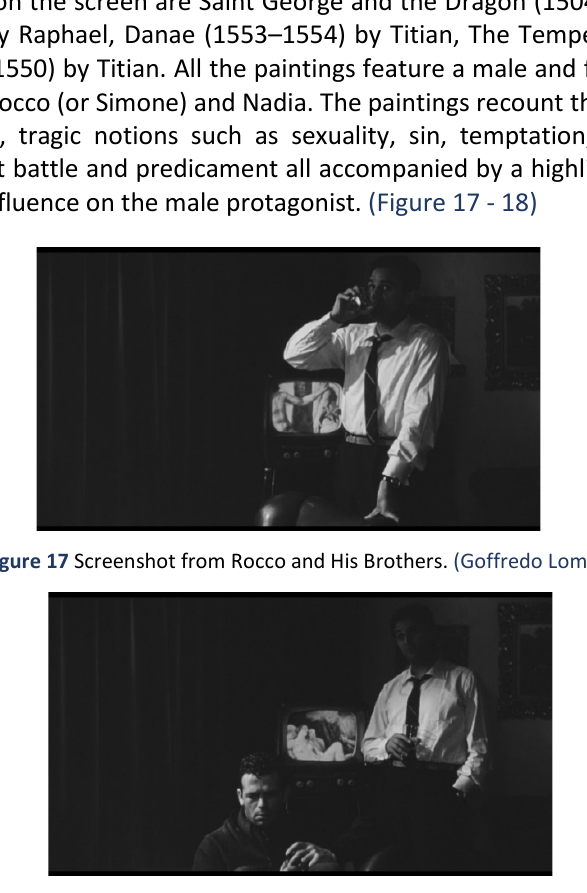
Figure 18 Screenshot from Rocco and His Brothers. (Goffredo